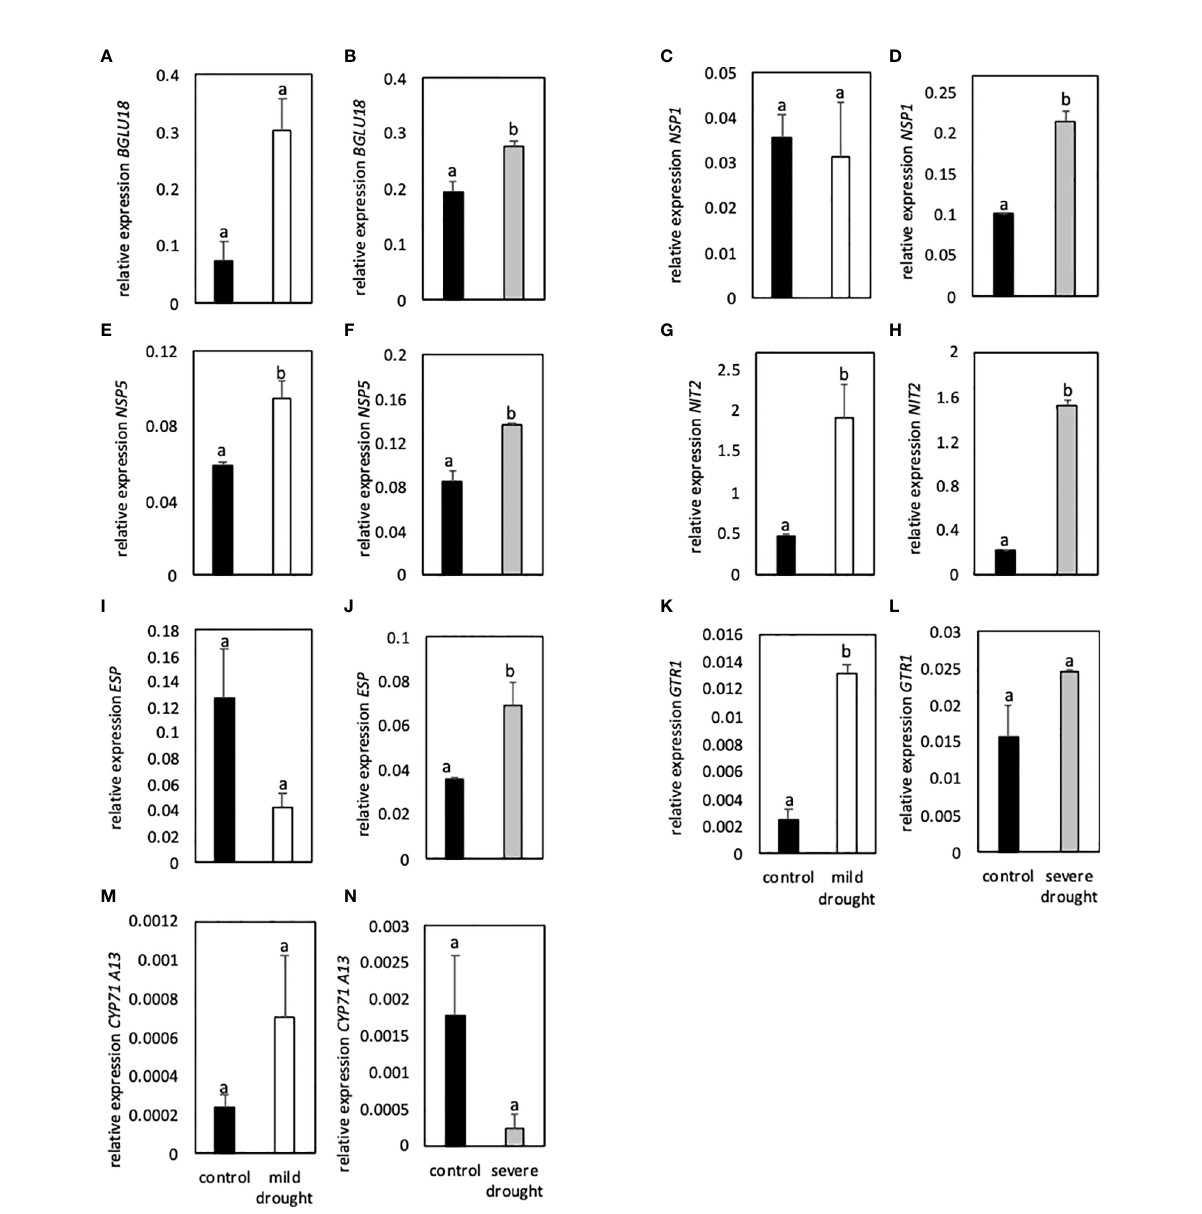
FIGURE 5 Relative expression of genes involved in glucosinolate breakdown ( BGLU18, NSP1, NSP5, ESP; A-F, I-J), modi fi cation of breakdown products ( Nit2, G-H ), transport ( GTR1 ; K-L) and synthesis of a key enzyme of indole-3-acetic acid synthesis ( CYP71A13 ; M-N) to the reference gene EF1 a . Plants were either subjected to 20% (mild drought stress, white bars) or 40% PEG 20,000 (severe drought stress, grey bars) for 7 days. Plants were grown on petri dishes for fi ve weeks prior to application of drought stress. Bars represent means of three biological replicates consisting of four pooled plants each. Different letters indicate signi fi cant differences (p<0.05) between control and drought-stressed